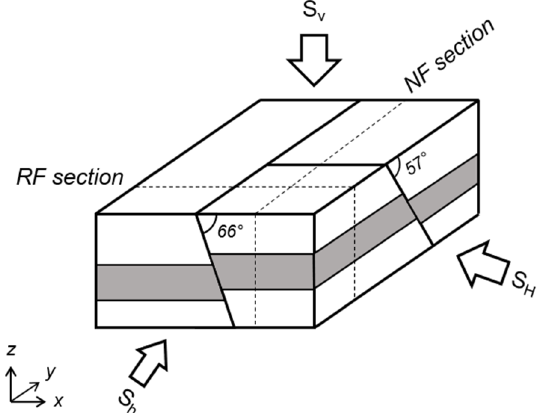
Figure 2. 3D schematic representation of the considered area. The normal fault (NF) section crosses the normal fault geometry and the reverse fault (RF) section crosses the reverse fault ge- ometry.